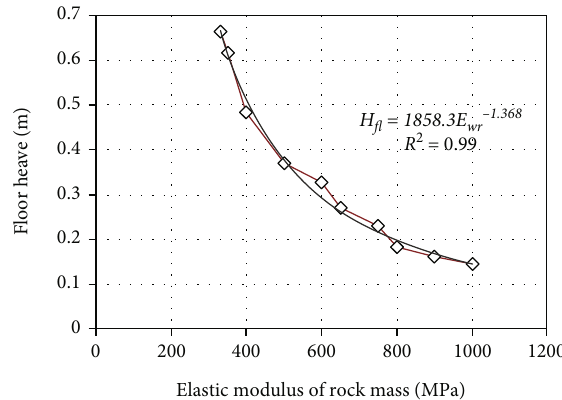
Figure 10: Graph of the dependence of fl oor heave ( H axis of the roadway from elastic modulus of wet rock mass ( E wr ) according to the results of numerical